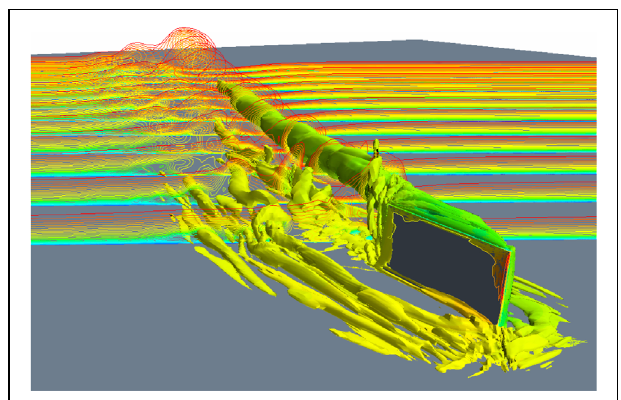
FIGURE 1 | Example of a numerical study of boundary layer control for aerodynamic performance optimization by a rectangular vortex